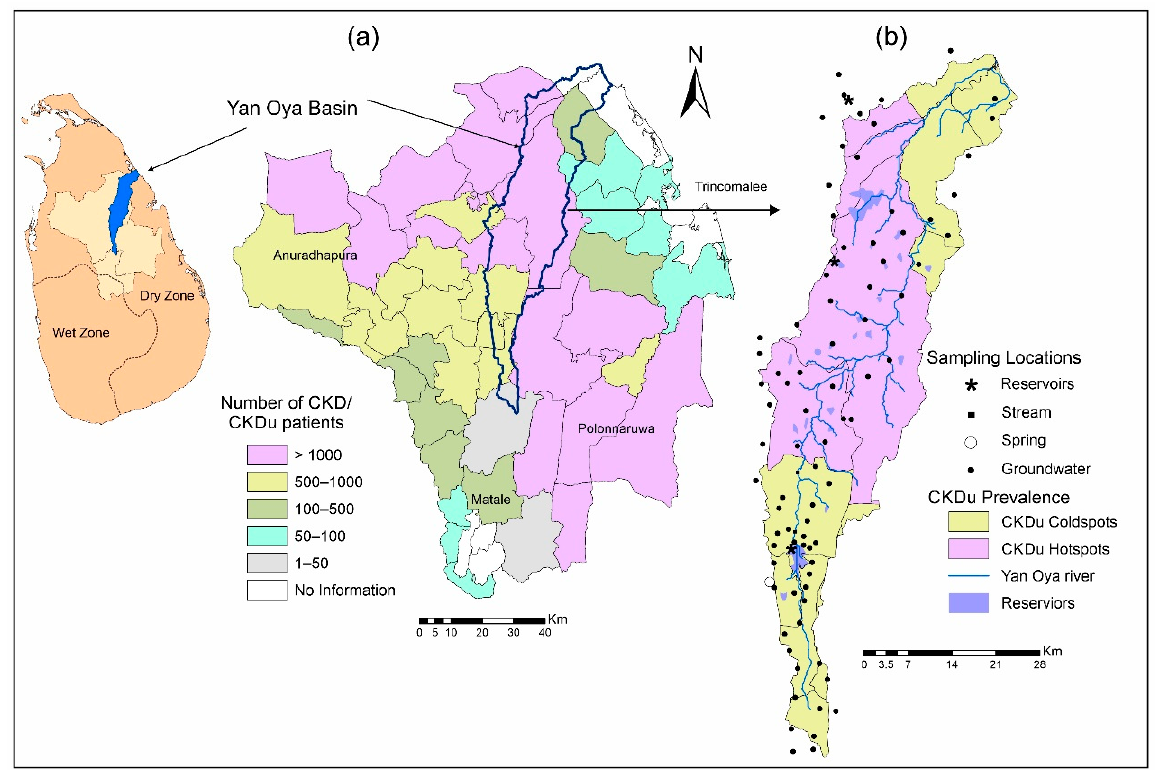
Figure 1. ( a ) CKD/CKDu prevalence in the north-central region of Sri Lanka (modified after Ranasinghe et al. 2019 [12]) and ( b ) sampling locations in the Yan Oya river basin.